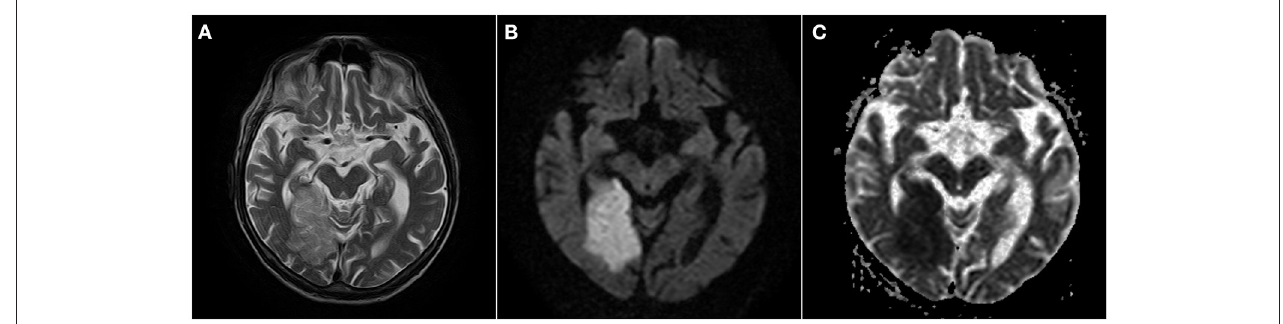
FIGURE 1 | Acute ischemic stroke in the right occipital lobe. Hyperintense area of edema is seen on T2-weighted image (A) . Diffusion restriction seen as marked hyperintensity on DWI (B) and reduced ADC values (C) .